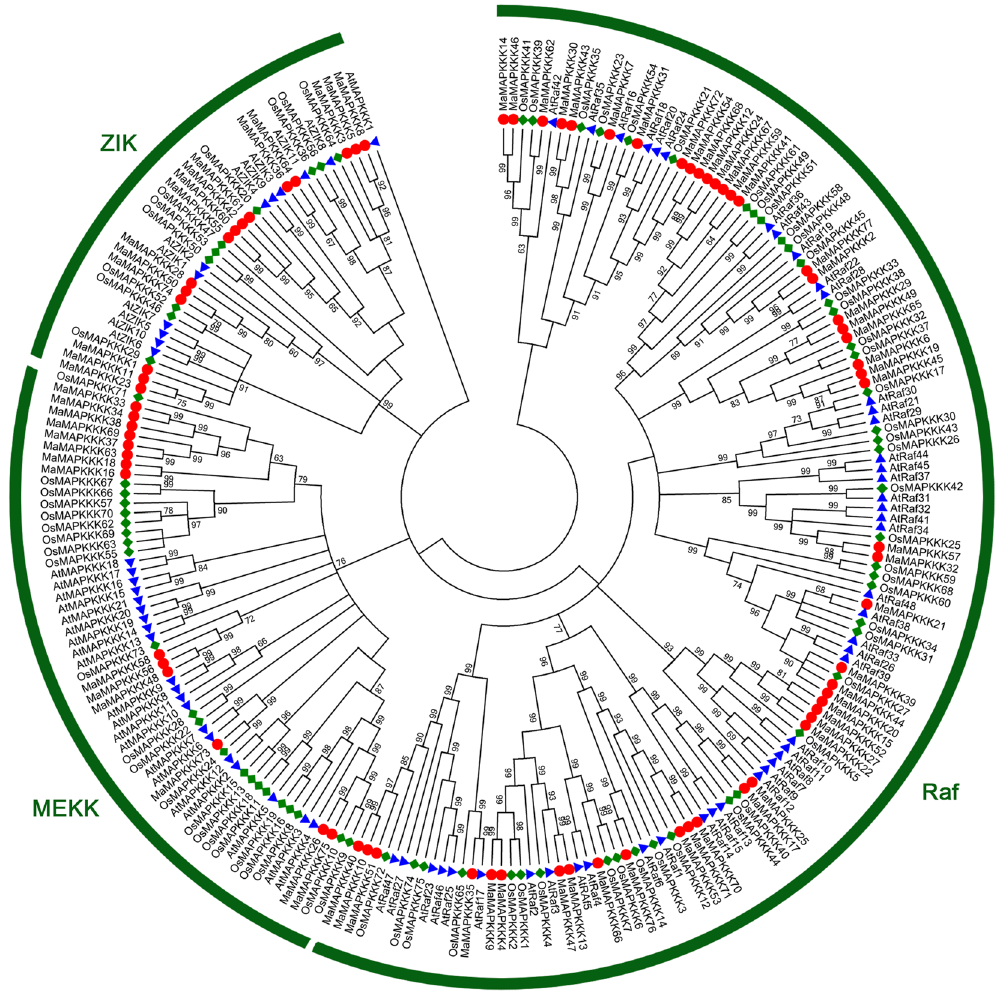
Figure 2. Phylogenetic analysis of MAPKKKs from banana, rice and Arabidopsis. The Neighbor-joining (NJ) tree was constructed using ClustalX 2.0 and MEGA 5.0 software with 1000 bootstrap replicates. Signs of different shapes represent MAPKKK proteins from banana (red round, Ma), rice (green rhombus, Os) and Arabidopsis (blue triangle,